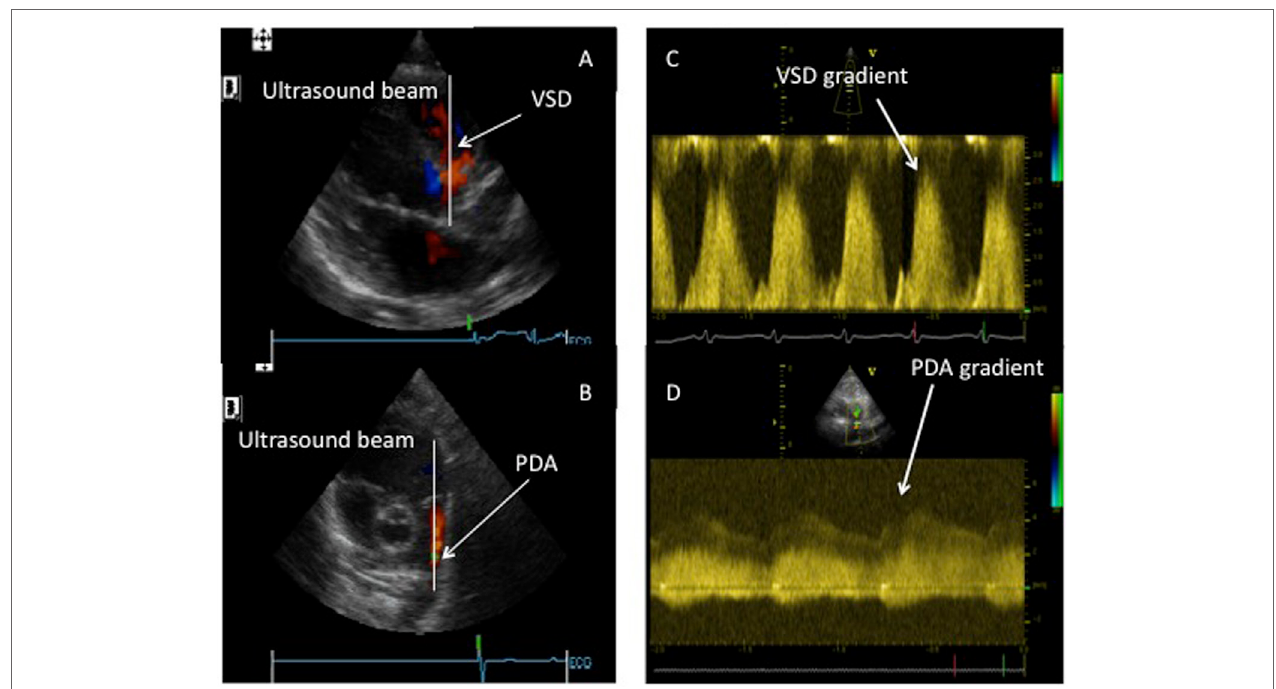
FigURe 3 | Assessment of systolic pulmonary pressure through the Doppler assessment of post-tricuspid shunts. (A) Doppler beam through a ventricular septal defect (VSD). (b) Doppler bean through a patent ductus arteriosus (PDA). (C) Doppler envelope of the VSD flow allowing for the measurement of the pressure gradient between systemic and pulmonary circulation. (D) Doppler envelope of the PDA flow allowing for the measurement of the pressure gradient between the systemic and pulmonary